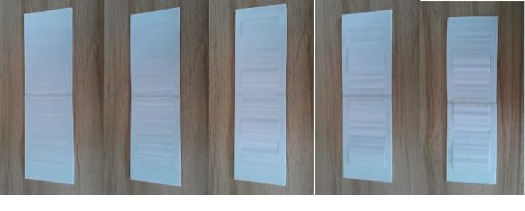
Figure 2: 3D printing fracture with different